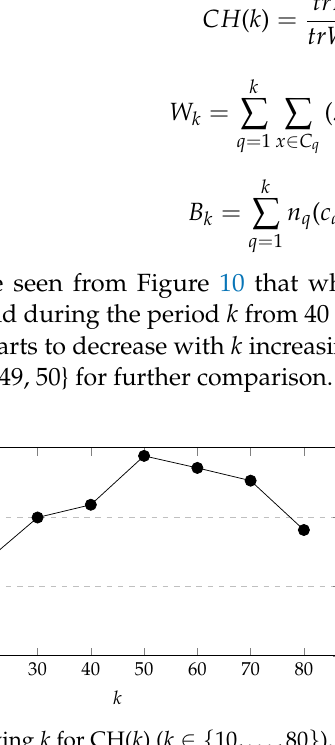
Figure 10. Varying k for CH( k ) ( k ∈ { 10, . . . ,80 } ).